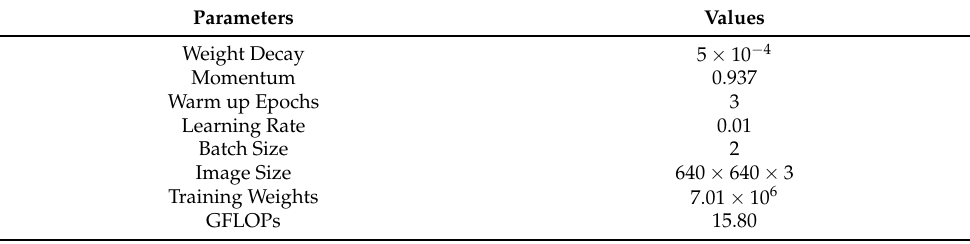
Table 8. Different hyper-parameters of the modified YOLOv5s